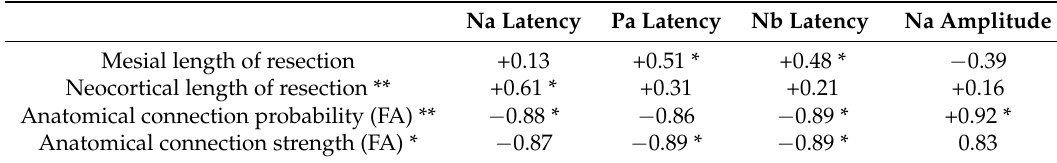
Table 4. Correlations between middle latency response and anatomical variables.